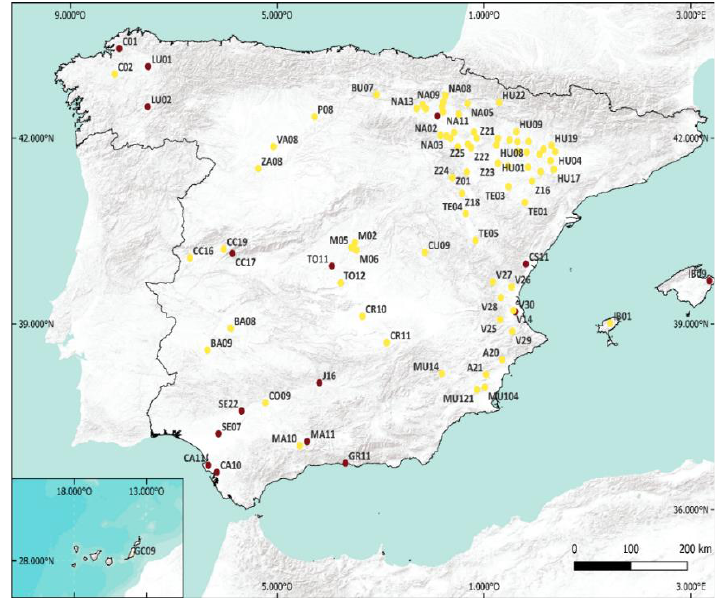
Figure 1. Positions of the weather stations considered in this study with solar data available from 1 January 2017 to 31 December 2020. In red, stations are not used because the data are not considered reliable. In yellow, the stations used. The geographical coordinates of the weather stations can be found in Reference [31].